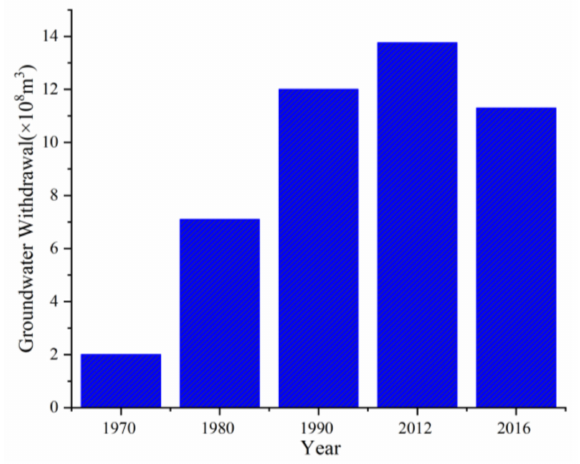
Figure 10. Groundwater exploitation in the mountain area of Yongding River.